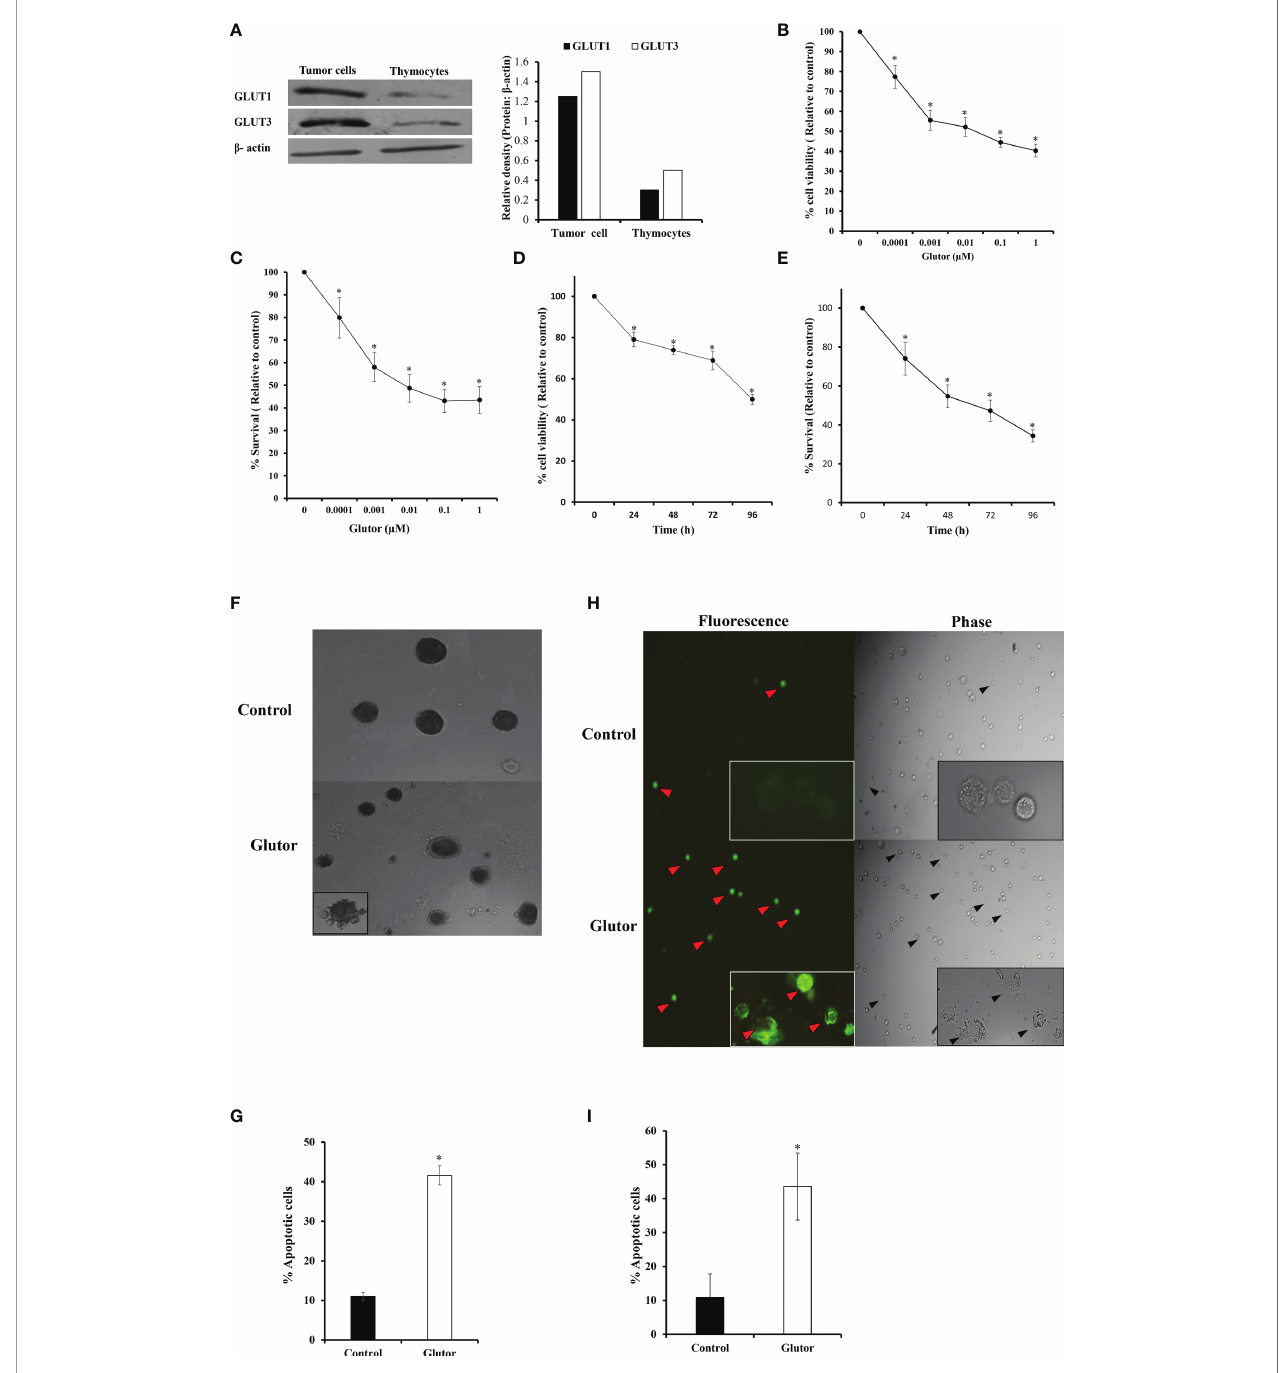
FIGURE 1 | Glutor exerts cytotoxic action on DL cells. DL cells or thymocytes (1 × 10 5 ) harvested from the thymi of healthy mice without tumor transplantation were processed for immunoblotting for GLUT1 and GLUT3 as described in the Materials and Methods section (A) . DL cells (1 × 10 5 ) were incubated in a medium alone or containing the indicated concentrations of glutor for 24 h (B, C) or with 0.01 µM of glutor for the various indicated time durations (D, E) , followed by estimation of cell viability by Trypan blue dye exclusion assay and cell survival by MTT assay as described in the Materials and Methods section. DL cells incubated in a medium alone or containing glutor (0.01 µM) for 24 h were examined for the mode of cell death by Annexin V/PI (H, I) and Wright – Giemsa (F, G) staining. Values shown in (B – E) and (G, I) are mean ± SD. The plates shown in (A) , (F) , and (H) are from a representative experiment out of at least two experiments with similar results. The bar diagram accompanying (A) is the densitometry of respective bands. * p < 0.05 vs. values of the respective